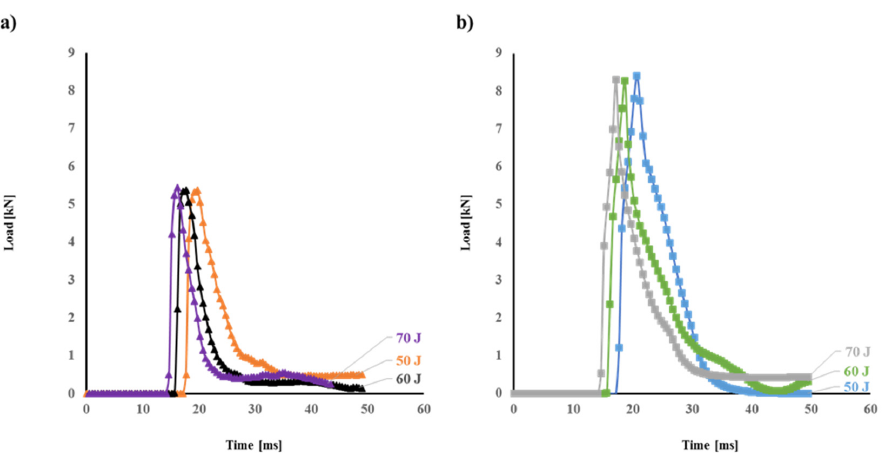
Figure 7. Typical load vs. time traces for 50 J, 60 J, and 70 J impacted ( a ) flax and ( b ) flax/basalt hybrid composites.